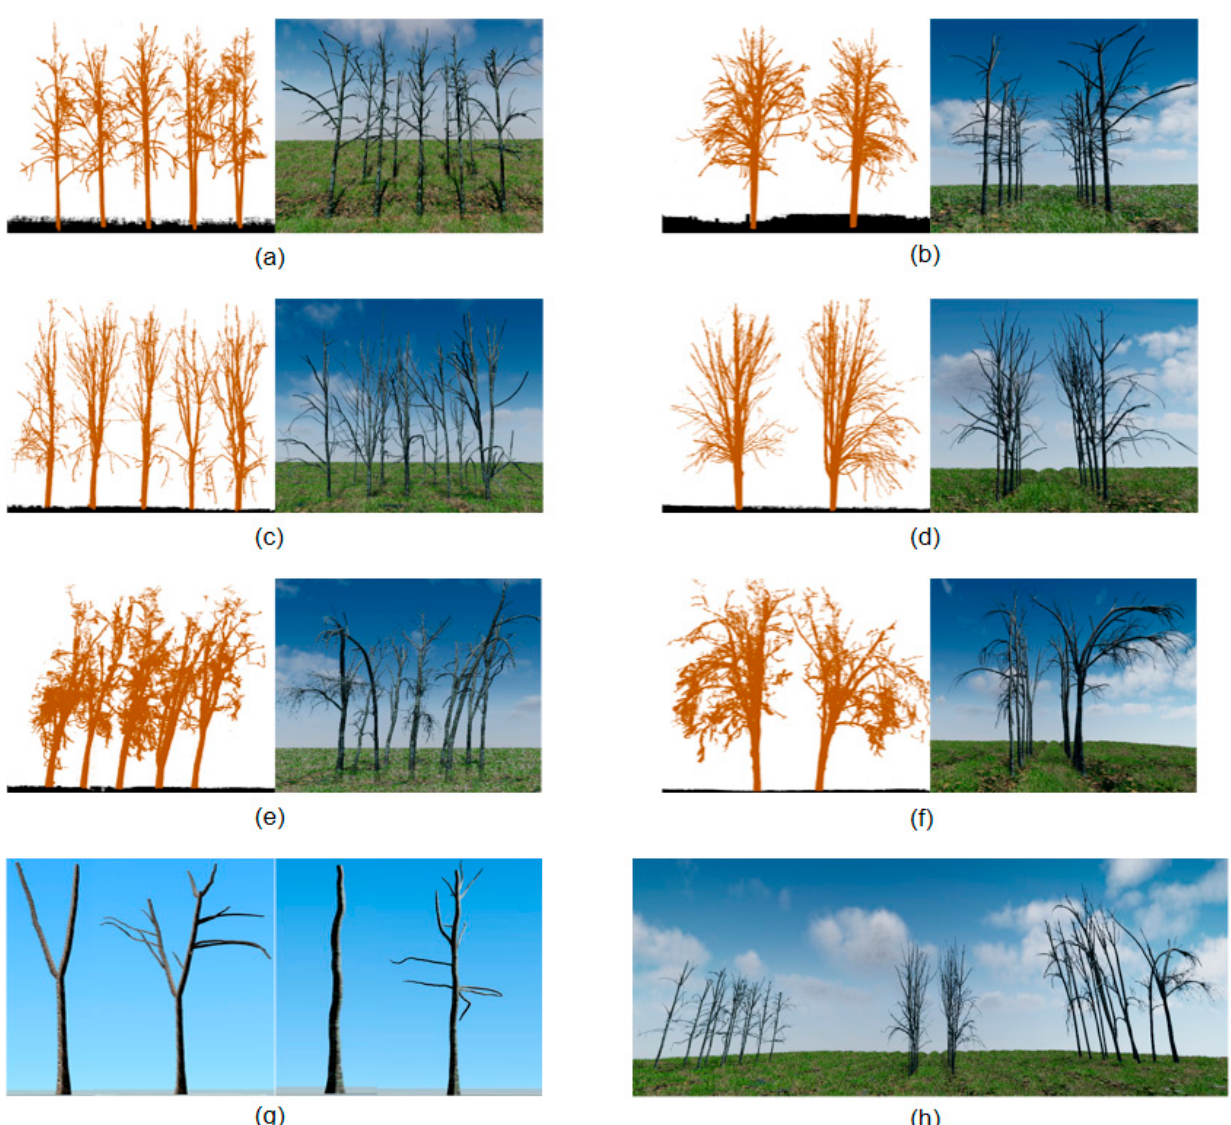
Figure 10. The modeling results of rubber tree skeletons of different ages based on the scanned points. ( a ) Original scanned points of rubber tree branches and ( b ) the reconstructed rubber tree models of 5 years old. ( c , d ) The equivalent figures for rubber trees of 10 years old. ( e , f ) The equivalent figures for rubber trees of 10 years old. ( g ) Detailed images of the resulting tree trunks and first order branches. ( h ) Overview of rubber tree models of various years.